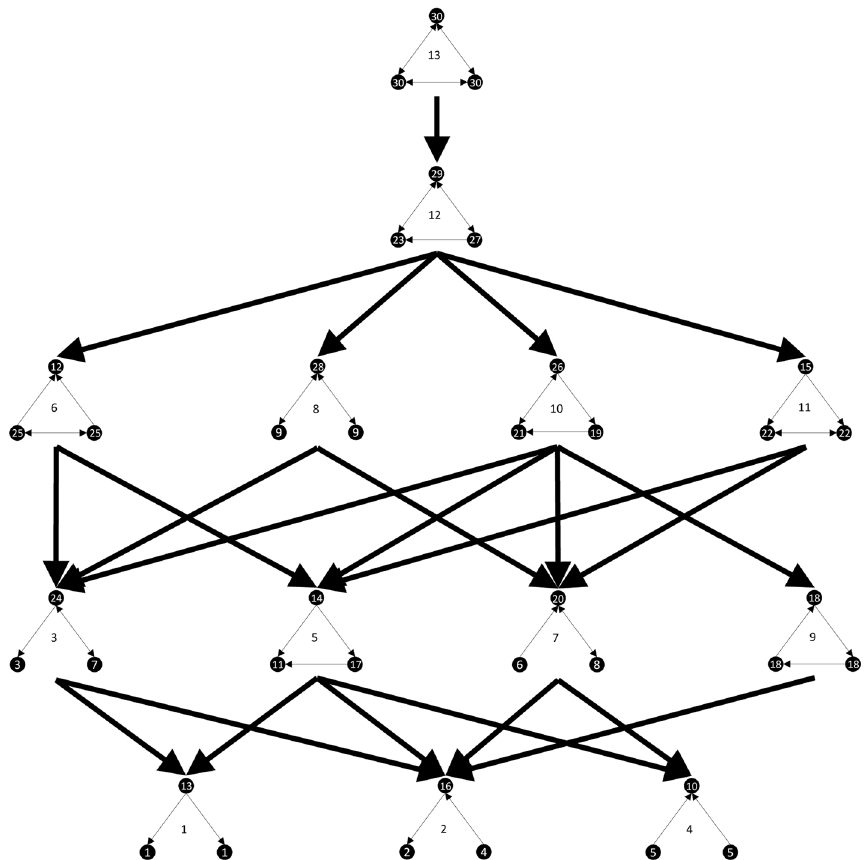
Fig. 4 Transition of roles in directed 3-node